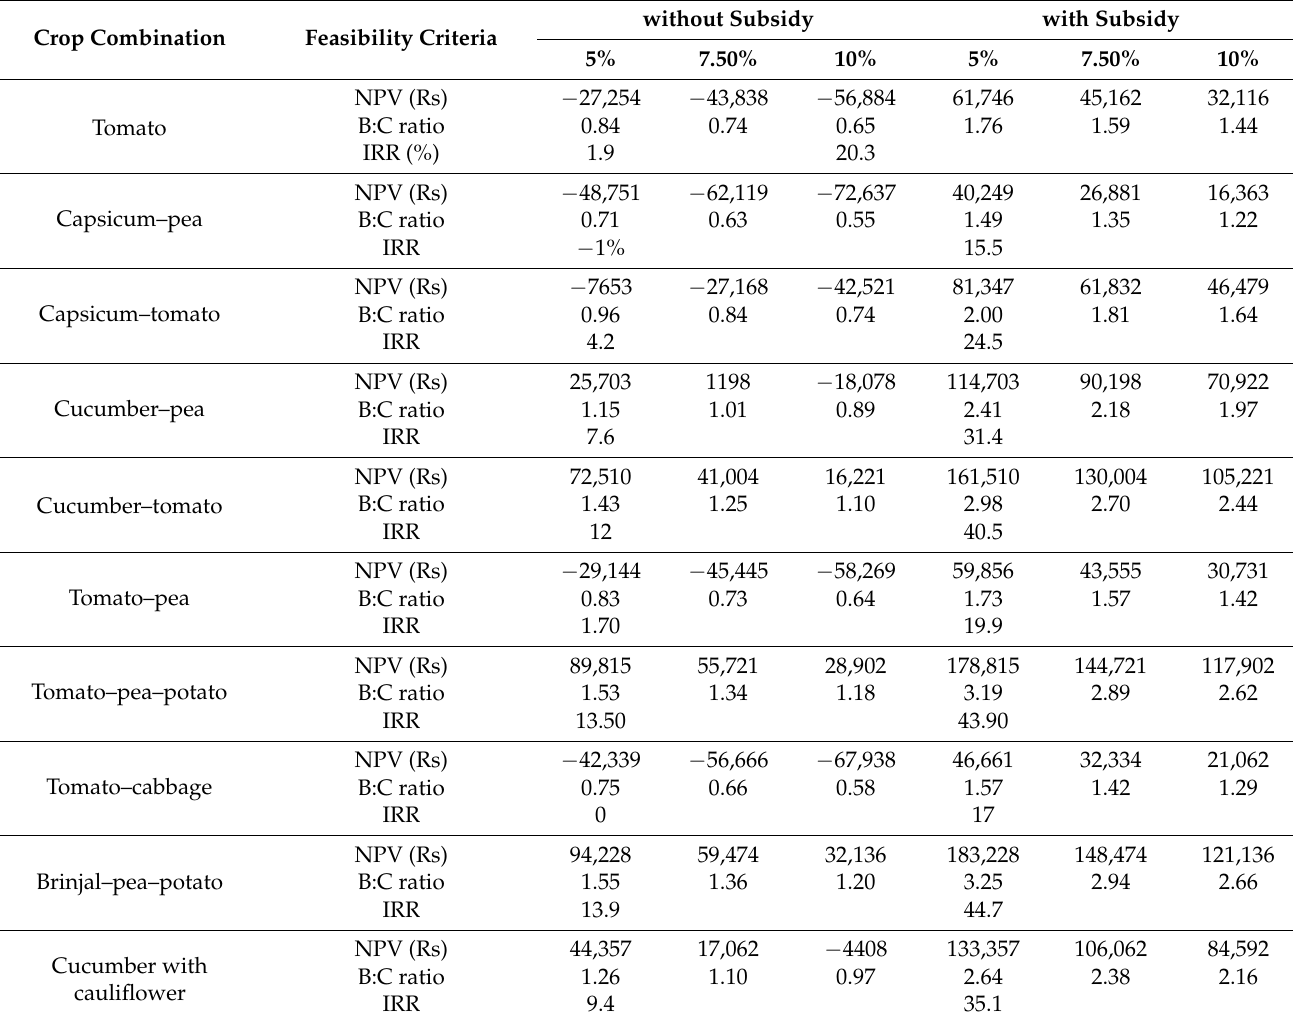
Table 14. Feasibility analysis of protected cultivation of vegetables under GI frame polyhouse in Almora district of